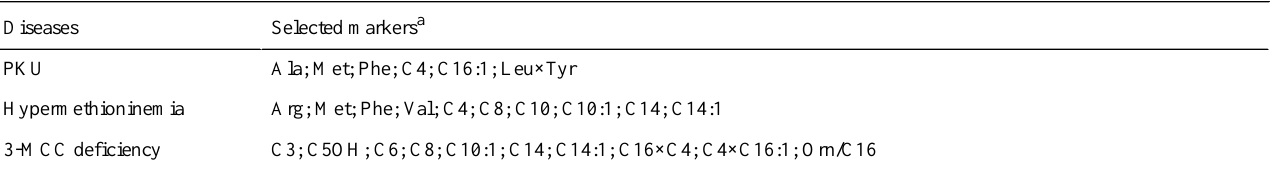
Table 2. Selected markers of the three diseases.